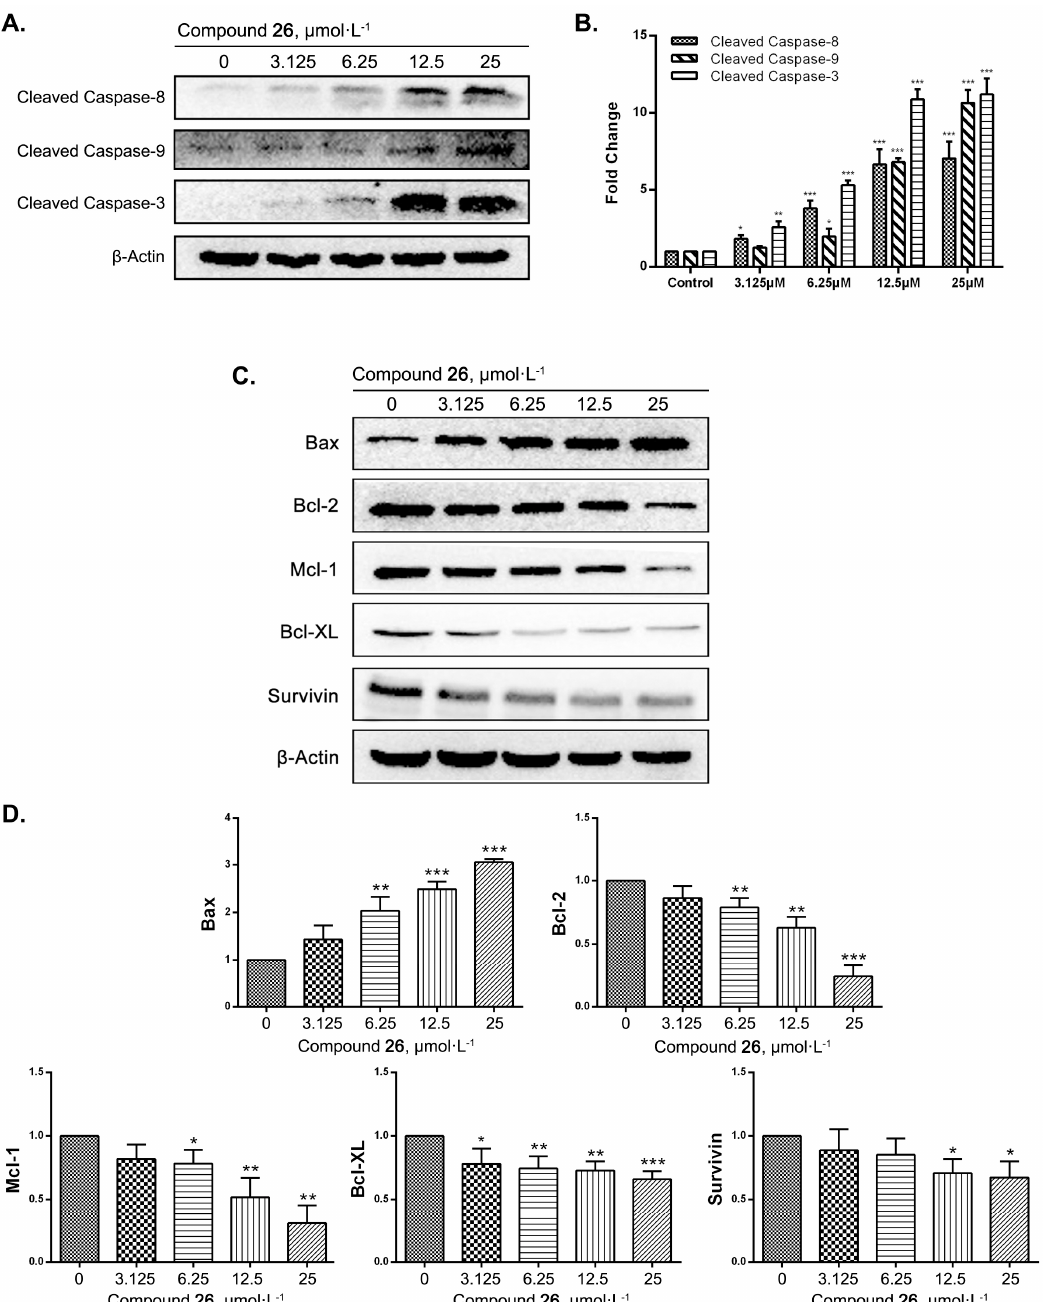
Figure 3. GXI induced HepG2 apoptosis via caspase cascade reaction and the mitochondrial pathway in HepG2 cells, HepG2 cells treated with various doses of GXI for 12 h. ( A ) Levels of cleaved caspase-8, cleaved caspase-9, and cleaved caspase-3 by Western blotting. ( B ) Fold change of Western blotting. Data represent mean ± SD. * p < 0.05, ** p < 0.01, *** p < 0.001 compared with control. ( C ) Levels of Bcl-2 family apoptosis-related proteins (Bax, Bcl-2, Mcl-1, Bcl-XL, Survivin and β -Actin) detected by Western blotting. ( D ) Fold change of Western blotting. Data represent mean ± SD. * p < 0.05, ** p < 0.01, *** p < 0.001 compared with control.